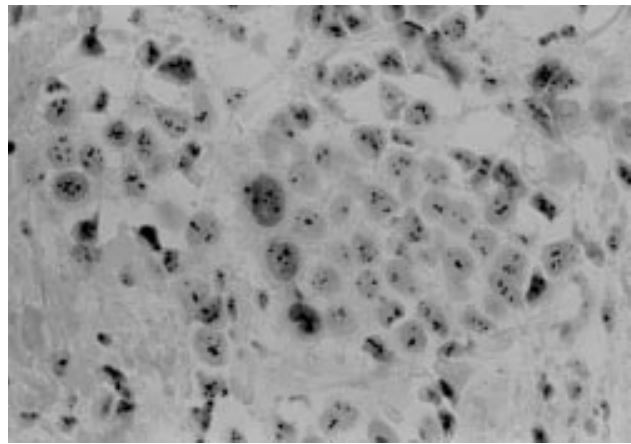
Fig. 4. Double staining for AgNORs and MIB1 in an invasive ductal carcinoma ( (cid:2) 400).